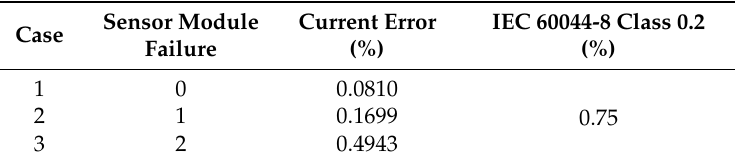
Table 3. Current errors of the proposed HCT with single-layer sensing structure in different sensor module failure situations when tested current is 5% of rated